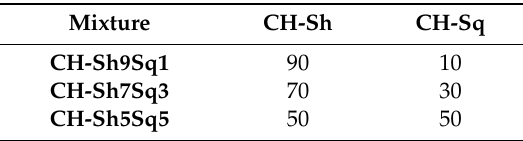
Table 9. Composition of CH mixtures (weight